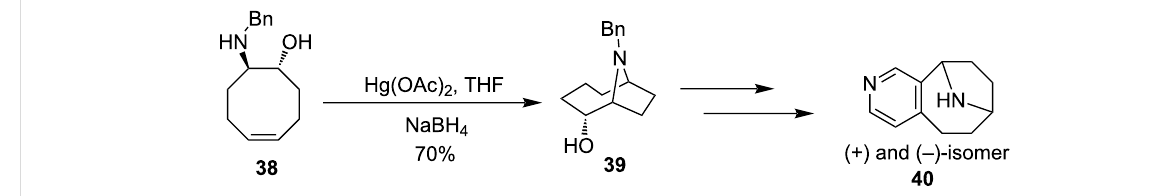
Scheme 15: trans -Amino alcohol formation through Hg(II)-salt-mediated cyclization.